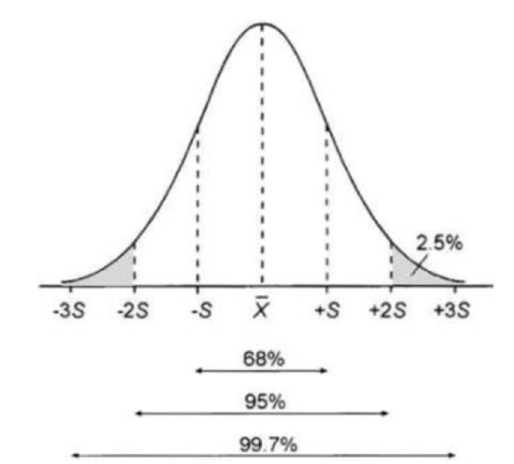
Fig. 2. A Gaussian or normal distribution.